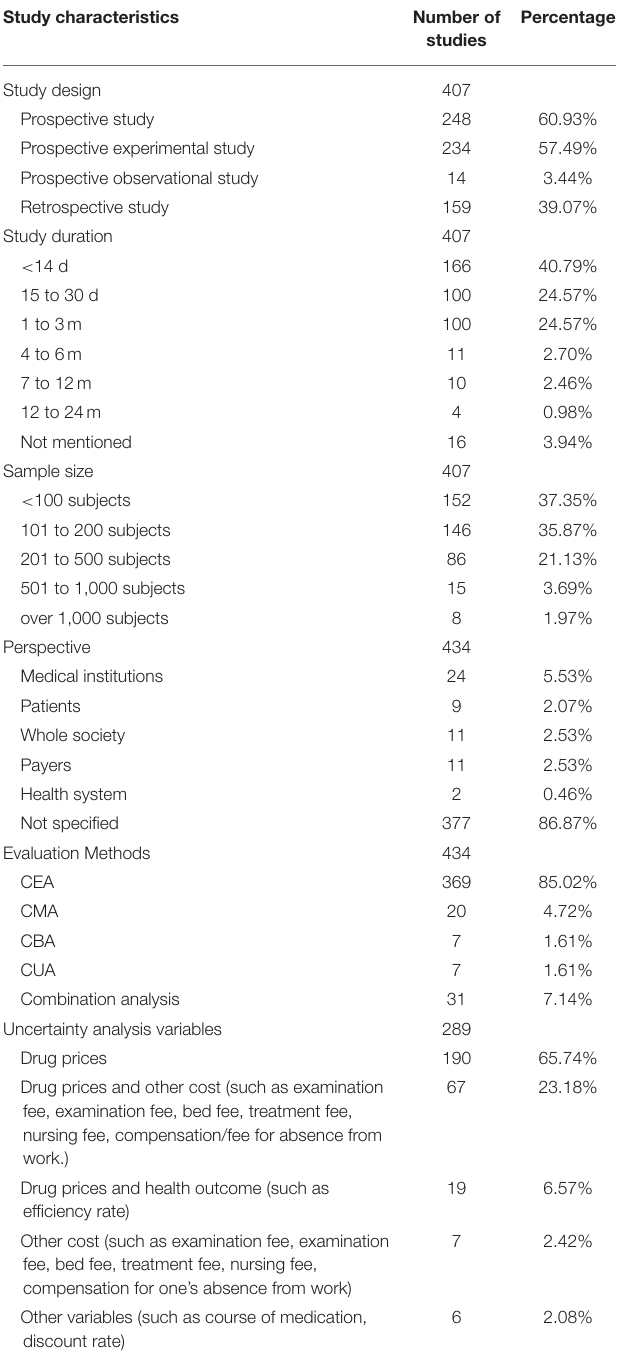
TABLE 3 | Characteristics and uncertainty analysis variables for included pharmacoeconomic studies ( N =